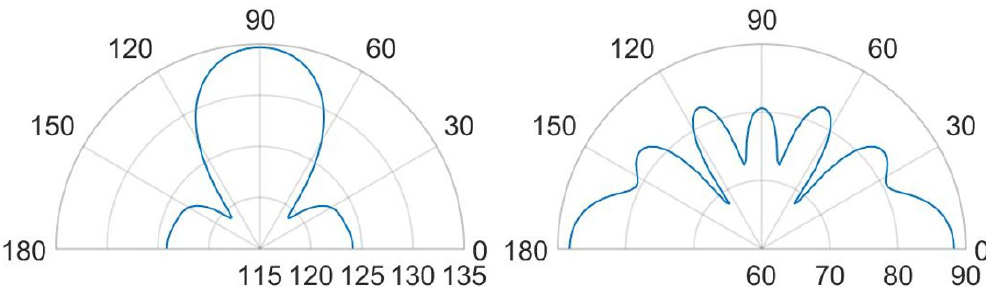
Figure 15. SPL polar plot (dB) at the performing fundamental frequency of 85.5 kHz (10 V bias), at 3.5 cm in the y(90 ◦ )-z(0 ◦ ) plane: unpackaged device ( left ), packaged device ( right ).